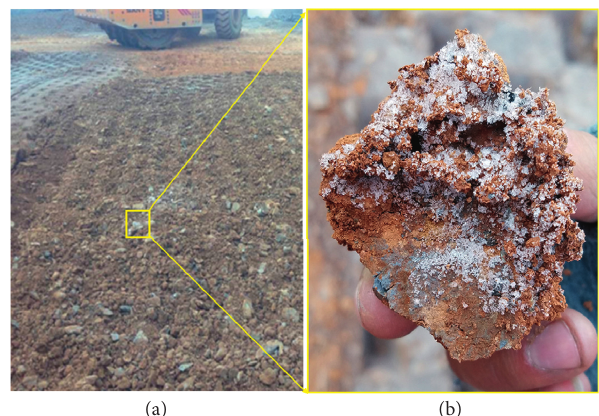
Figure 4: Photograph of the thin-layered cryostructure inside contact clay on-site.